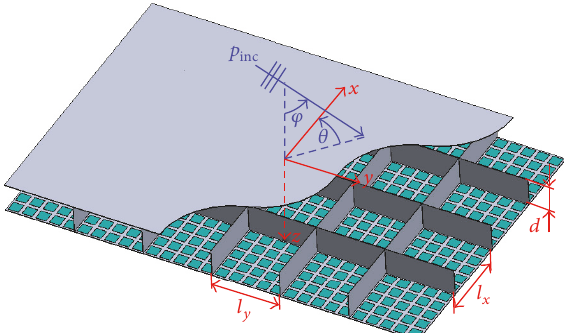
Figure 1: Research model of an orthogonally rib-stiffened sandwich structure with periodic subwavelength arrays of shunted piezoelec- tric